Question: Which visualization type does this figure use?
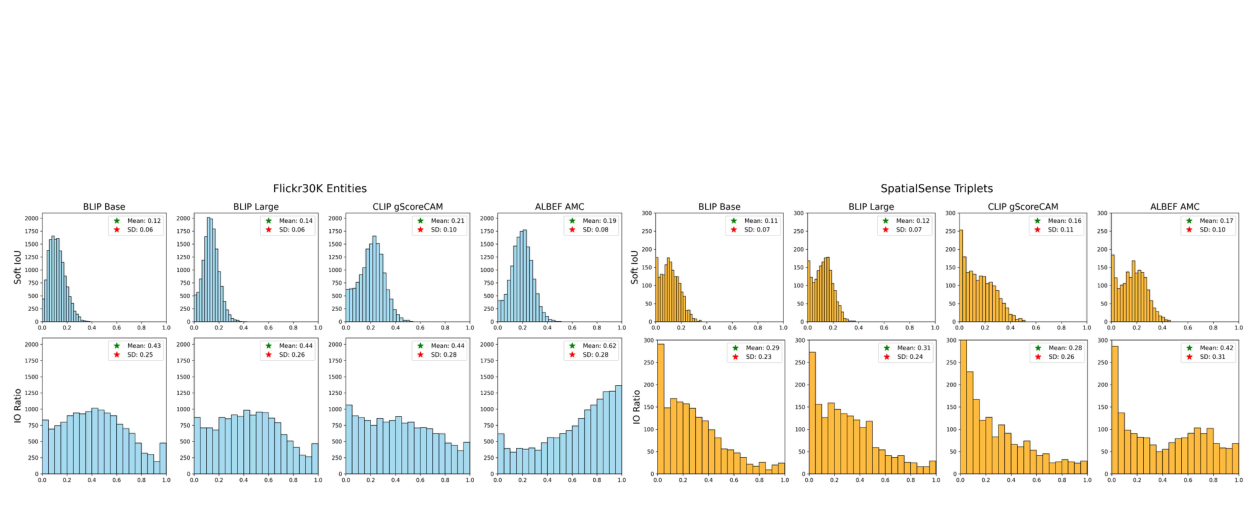
Answer: histogram